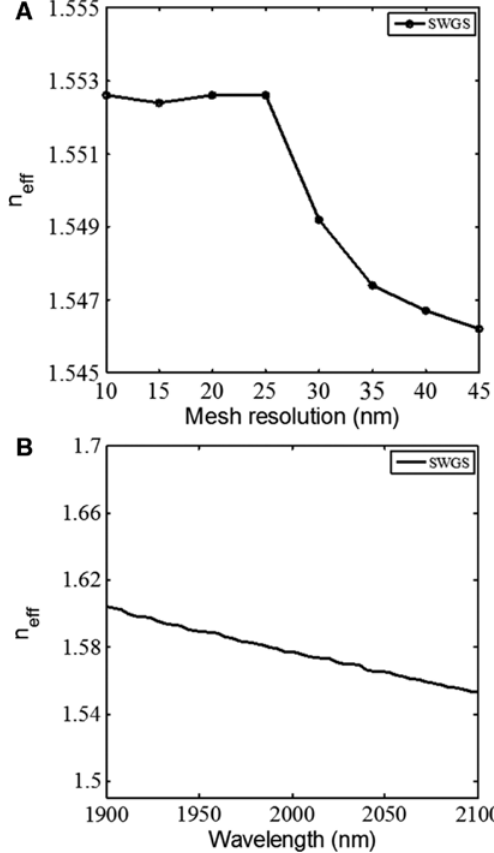
Figure 5: Effective refractive index as functions of the mesh resolu- tion and wavelength. (A) Calculated effective refractive index of SWGS waveguide at 2100 nm vs. mesh resolution. (B) Calculated effective refractive index of SWGS waveguide vs. wavelength. The mesh resolution is set as 20 nm.